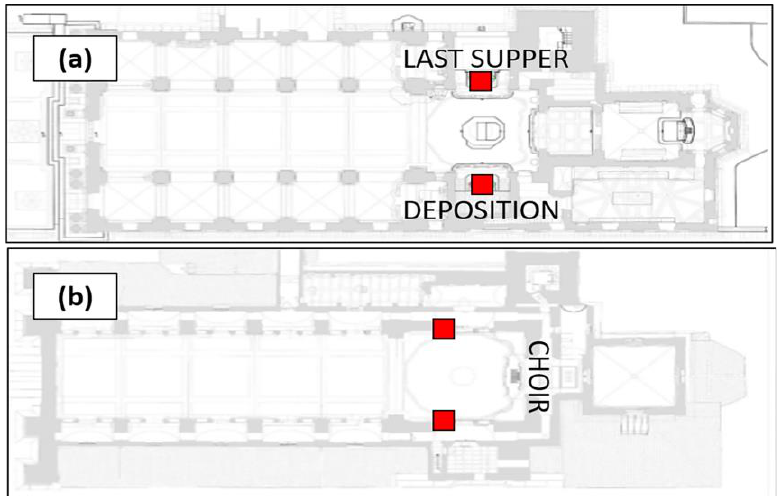
Figure 12. Planimetry of ( a ) the ground floor and ( b ) the first floor showing the three sampling